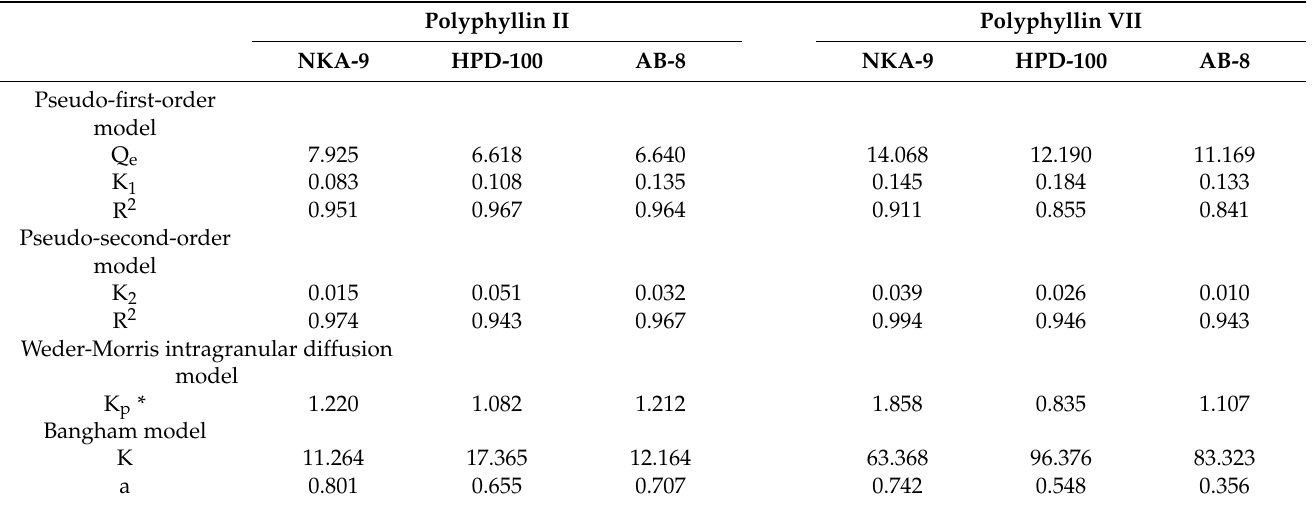
Table 3. Summary of obtaining parameters from different